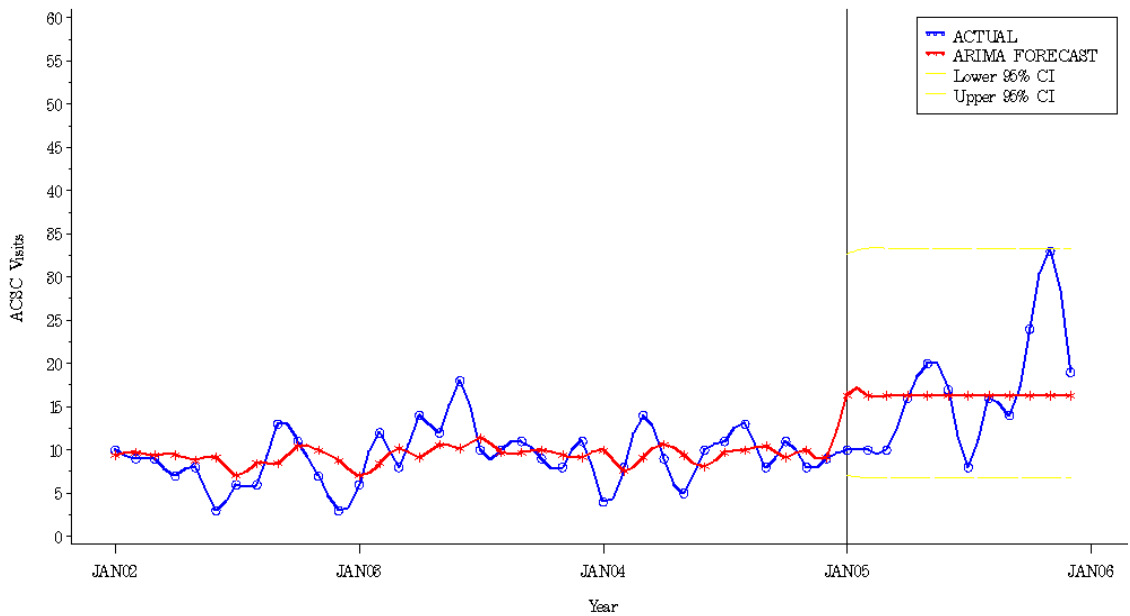
Figure 3. Model Actual vs. Predicted Plot of Primary Care Visits to a Federally Qualified Health Center with 95% Confidence Band for Direct Group: SC Medicaid Beneficiaries, 2002 –